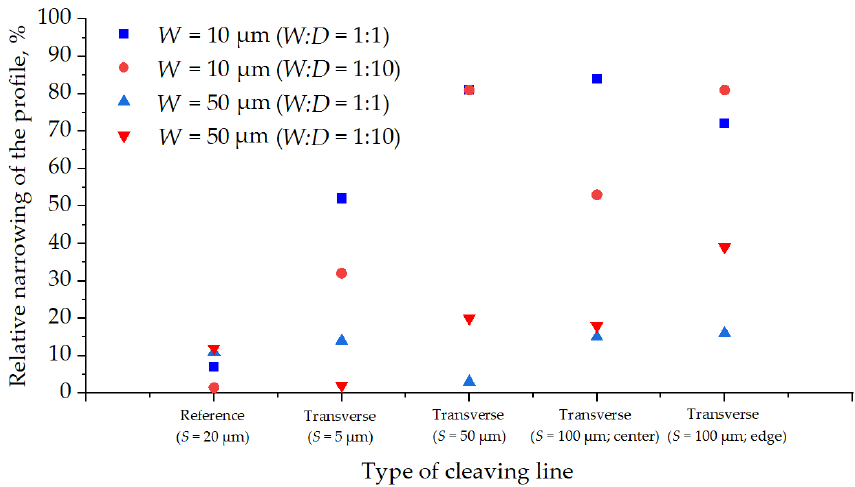
Figure 16. The relative narrowing of the profile per trench width depending on the type of cleaving line.